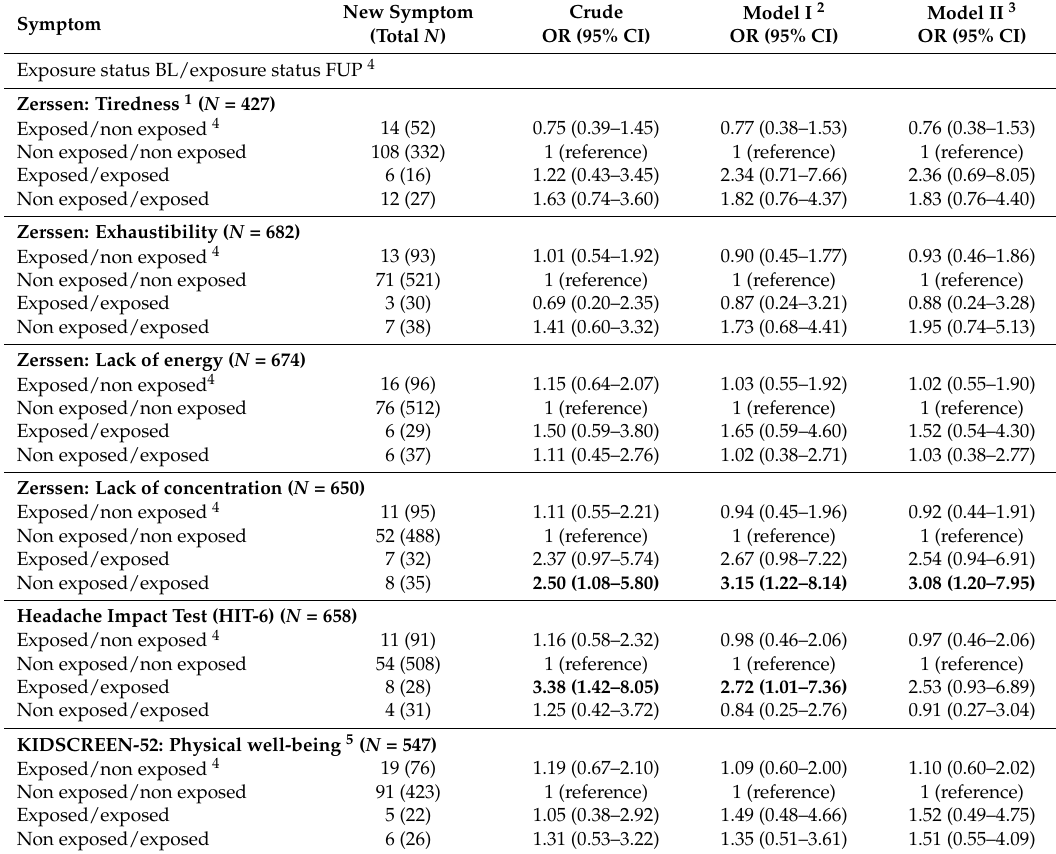
Table 3. OR to develop symptoms between BL and FUP in relation to nocturnal awakenings due to incoming mobile phone calls or text message. Significant associations are displayed in